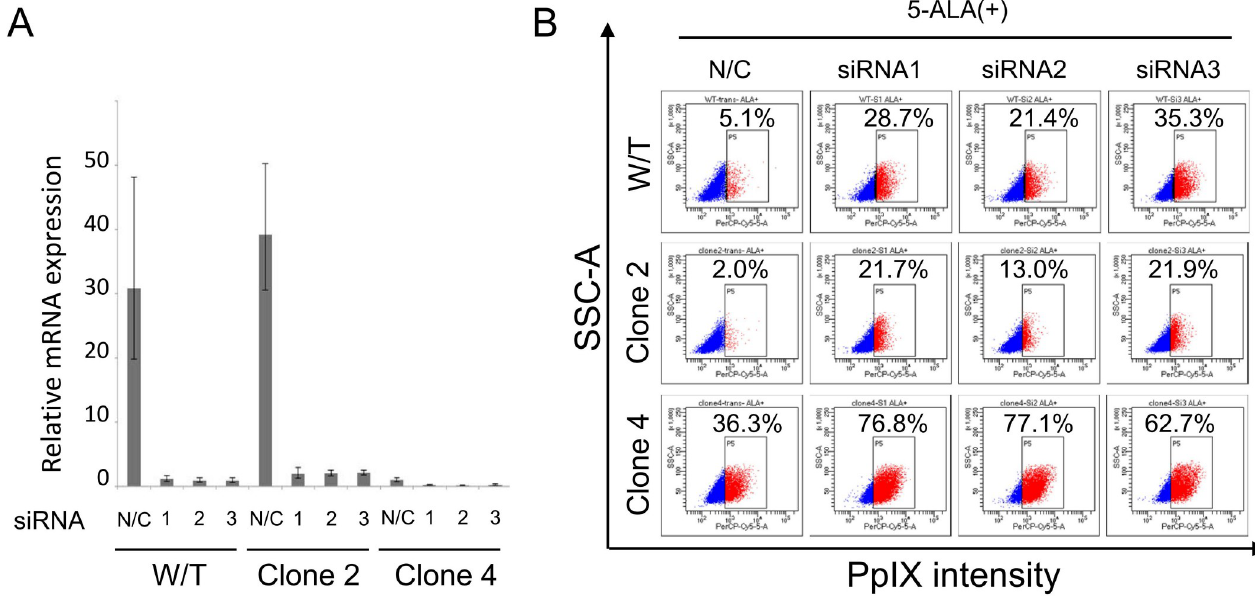
Fig 4. Knockdown of ABCG2 in PANC-1 clone cells increases 5-ALA staining. (A) qRT-PCR analysis of ABCG2 expression. PANC-1 W/T cells, clone #2 cells, and clone #4 cells were transfected with ABCG2 siRNAs. At 2 days after transfection, ABCG2 expression was analyzed by qRT-PCR. Data are shown as the mean ± standard deviation. (B) FACS analysis of 5-ALA-stained ABCG2 knockdown cells. PANC-1 W/T cells, clone #2 cells, and clone #4 cells were transfected with ABCG2 siRNAs. At 2 days after transfection, the cells were stained with 5-ALA (150 μ g/mL) for 4 h and analyzed by flow cytometry. Percentages indicate the positive rates of PpIX